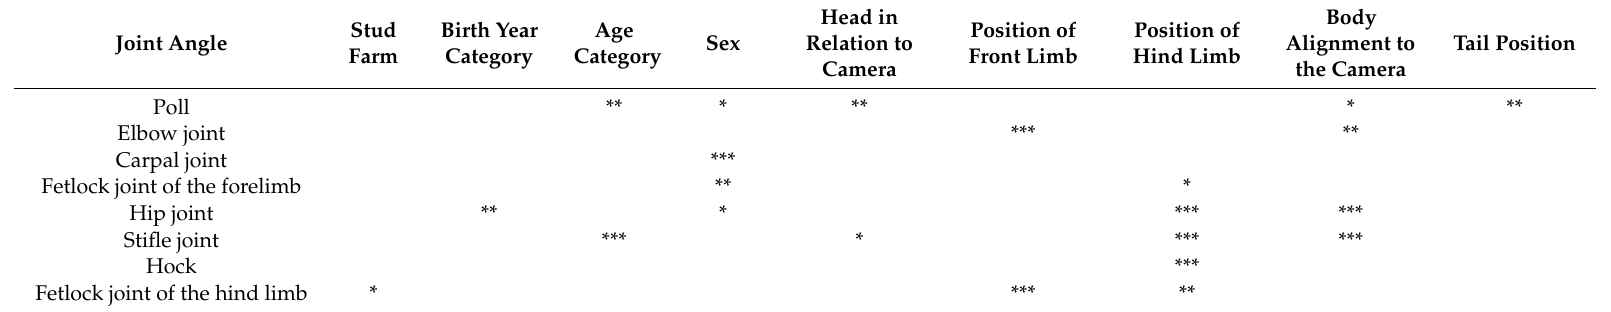
Table 2. Summary table of the significance of the covariates in the full polygenic model.